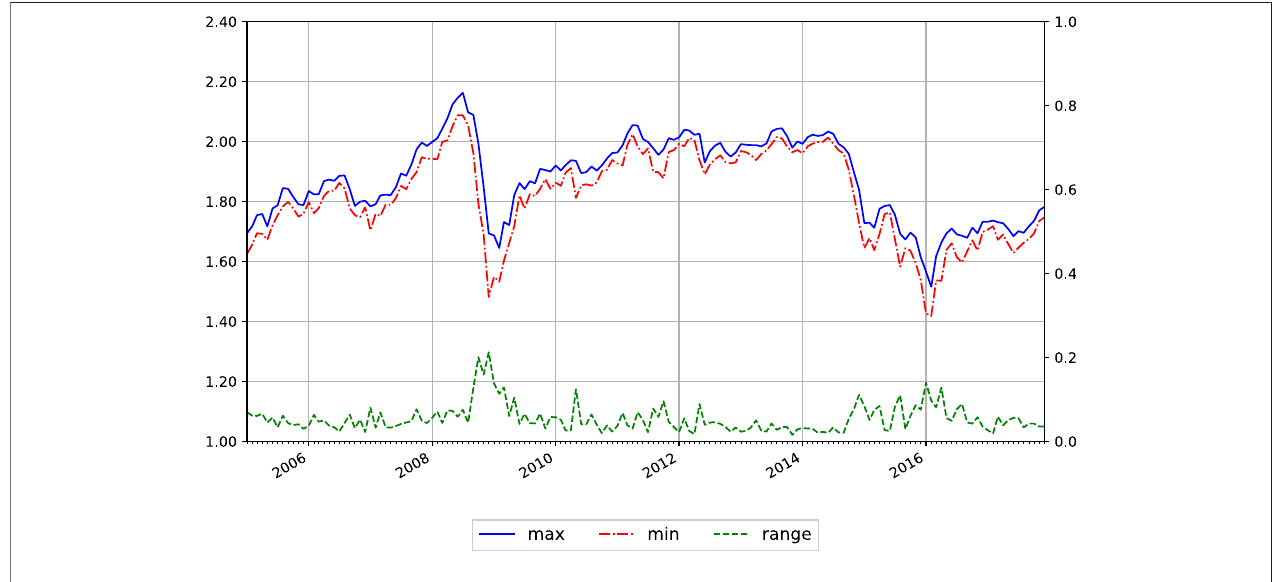
FIGURE 2 | Interval valued crude oil prices from EIA, January 2005 – December 2017.